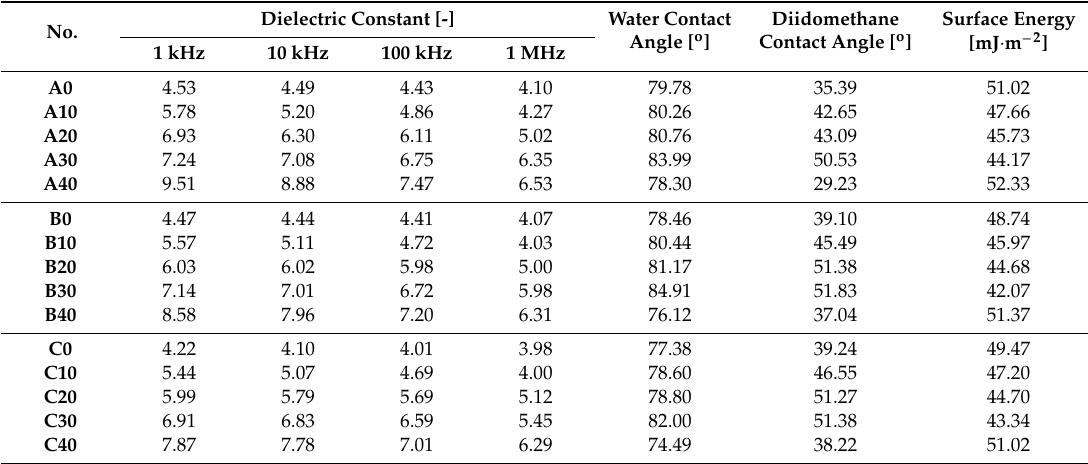
Diidomethane Surface Energy Angle [ o ] Contact Angle [ o ] [mJ · m − 2 ]